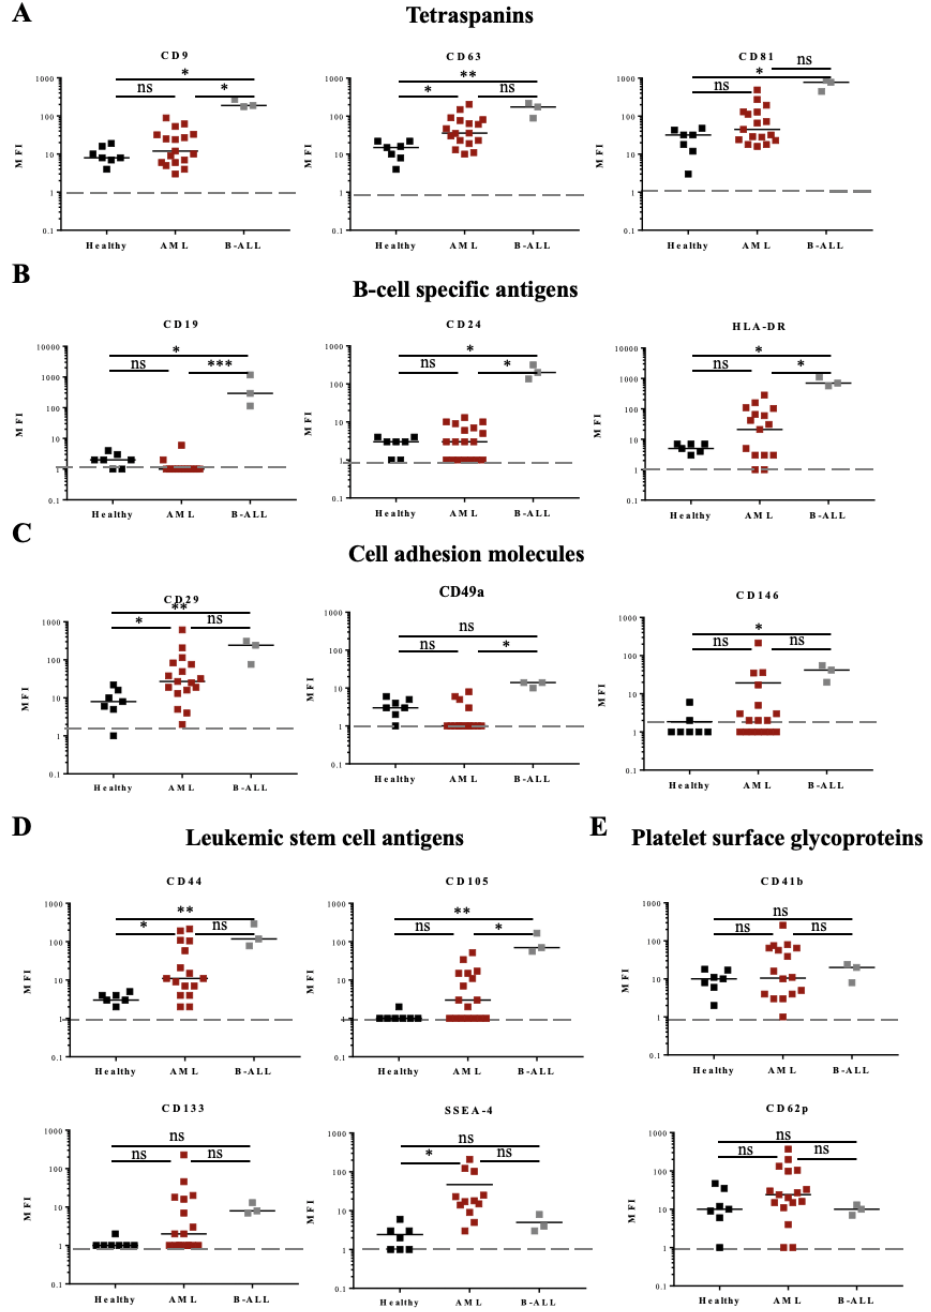
Figure 6. Fifteen antigen expressions from HBD, AML, and B-ALL patients by multiplex